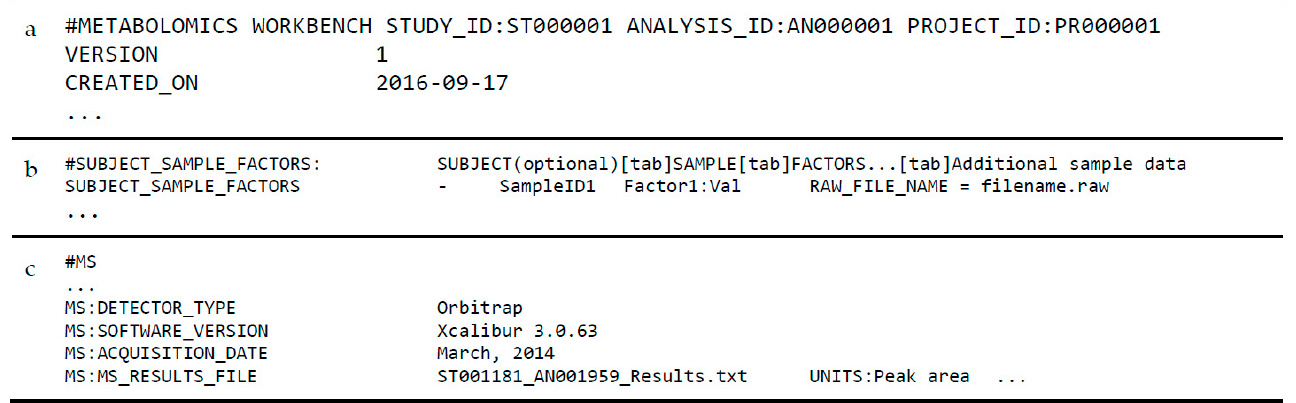
Figure 3. Overview of the updated ‘mwTab’ format: ( a ) Updated header block which now includes ‘PROJECT_ID’ key-value pair; ( b ) Uploaded ‘SUBJECT_SAMPLE_FACTORS’ block format with the additional ‘RAW_FILE_NAME’ field in the ‘Additional sample factors’ column; and ( c ) Updated ‘MS’ block format with additional key-value pairs appended to ‘MS:MS_RESULTS_FILE’ line.